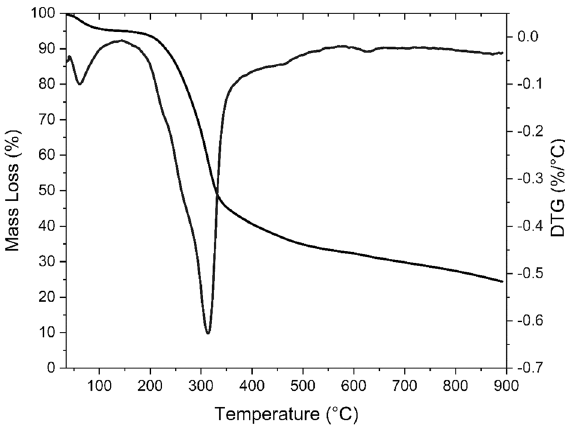
Figure 2. Biomass thermogravimetric curves (TG/DTG).